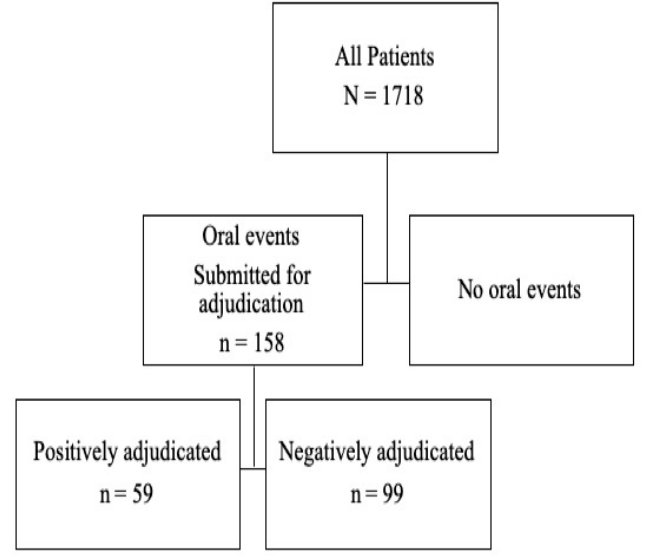
Figure 1. Summary of adverse oral events submitted for adjudication.